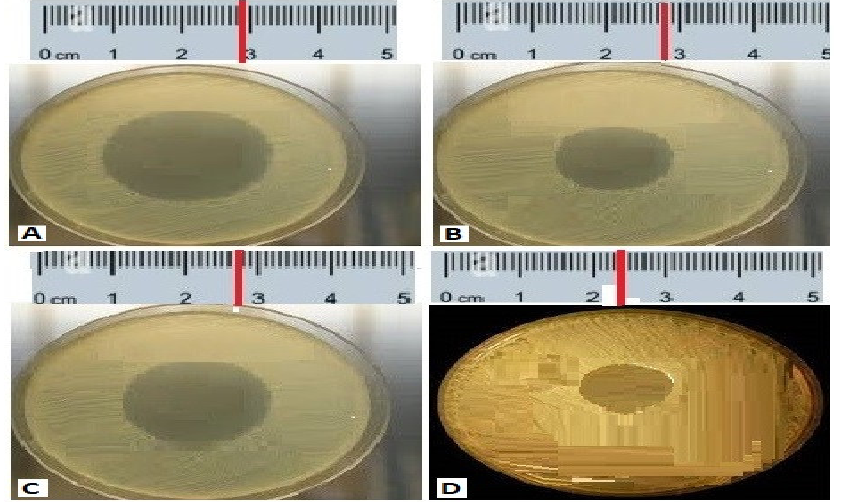
Figure 1. The antibacterial activity of compounds isolated from the isolated code A1 S10 Paenibacil- lus against MDR strains ( A ) S. aureus 28.22 mm, ( B ) P. aeruginosa 28 mm, ( C ) K. Pneumoniae 27 mm, ( D ) Acinetobacter baumannii 21 mm.